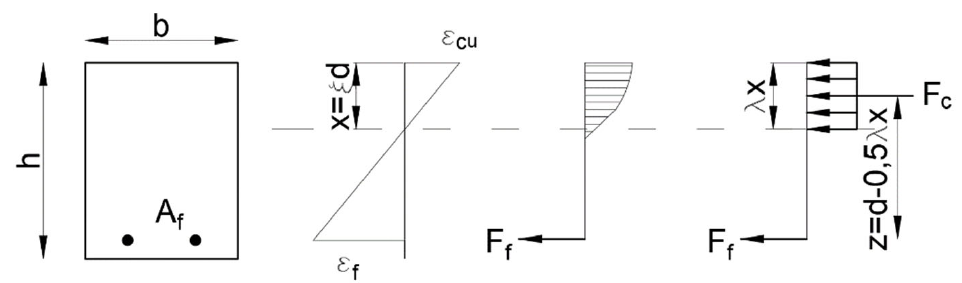
Figure 11. Equilibrium conditions of the FRP cross section.